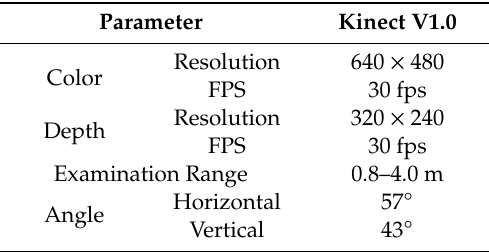
( c ) Figure 5. ( a ) Z = 1.8 m indoor depth map result; ( b ) Z = 1.8 m daytime outdoor depth map result; and ( c ) Z = 2.2 m night outdoor depth map result. After processing the experimental data, the average error distribution at different intervals is compared as shown. It can be seen from the comparison of the system errors of the camera under different conditions in Figure 6 that the outdoor system error generally satisfies with the increase of the measurement distance. In contrast, the indoor system error has no obvious law and the distribution is relatively random. After comparing indoors and outdoors, the range of indoor system errors is small, so the camera is measured indoors and the light is more dark and soft.